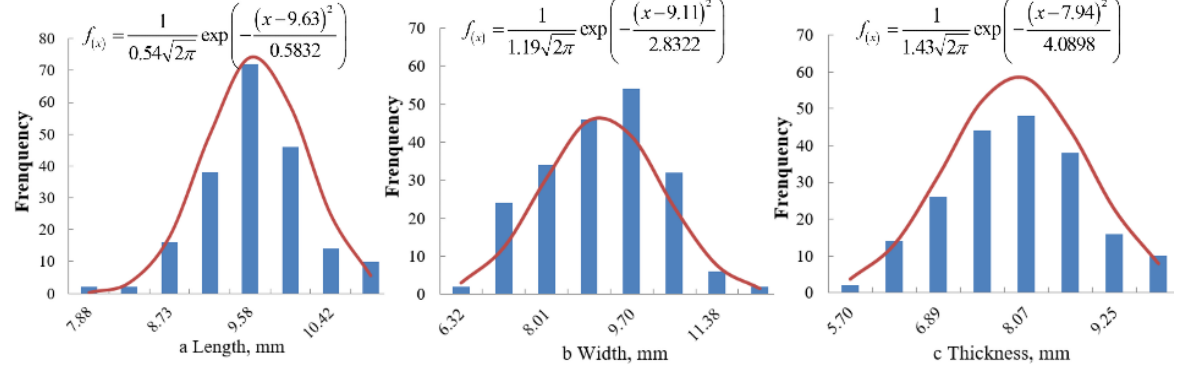
Figure 2. Distribution of the size of Jinong 1 seeds: ( a ) length; ( b ) width; and ( c ) thickness.